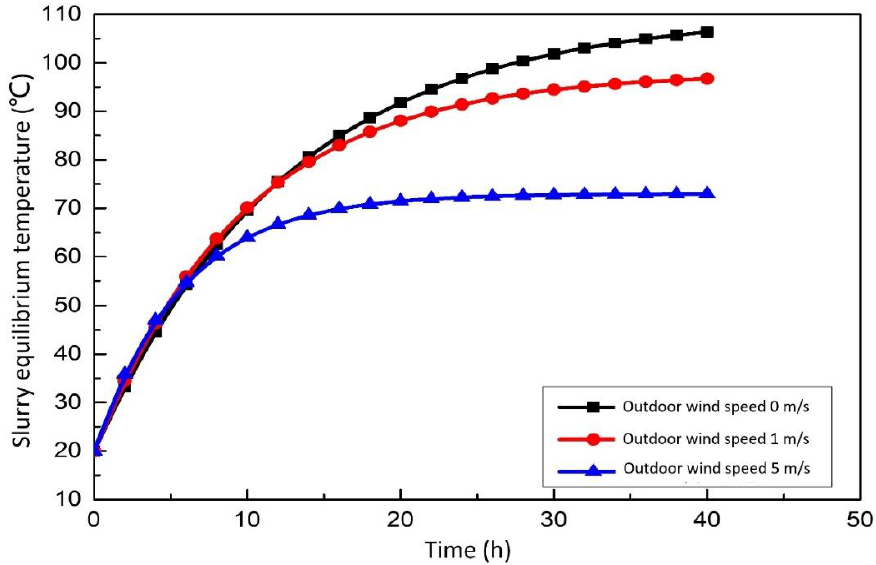
Figure 7. Effect of wind speed on the slurry equilibrium temperature.